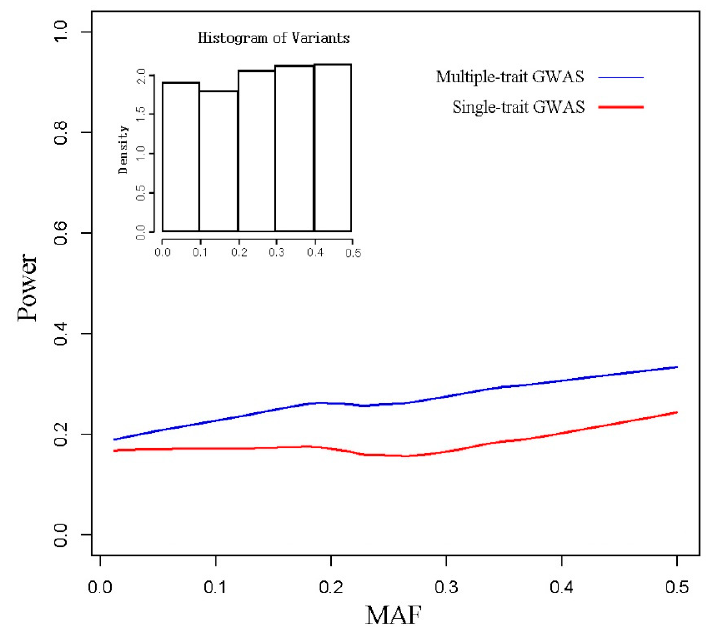
Figure 3. Comparison of detection power between multiple-trait GWAS and single-trait GWAS in different minor allele frequencies. MAF: minor allele frequency. Upper left figure reveals a histogram of the minor allele frequency in the simulated data.